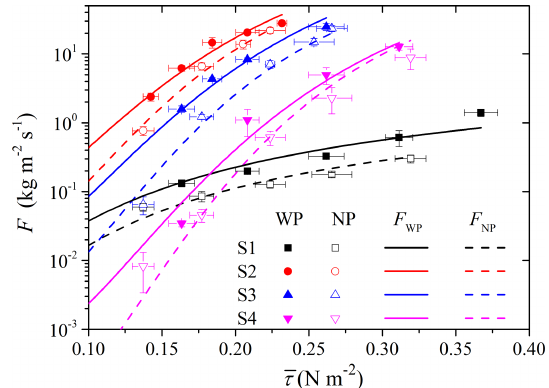
Figure 6. Estimated entrainment rates with and without forced per- turbation. The dots are experimental data, and lines derive from Eq. (12).